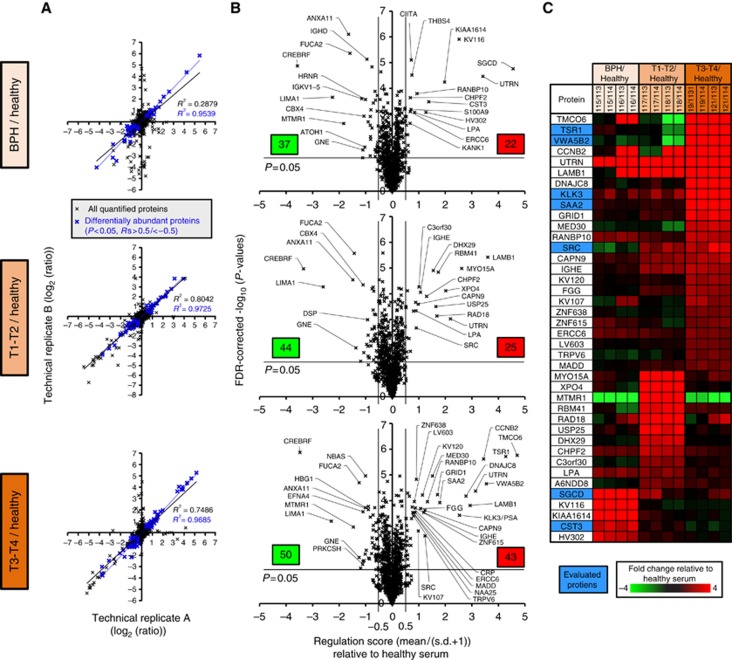
Summary of the reproducible differential serum protein abundance observed in BPH, T1–T2 and T3–T4 relative to healthy serum.(A) The reproducibility between technical replicates for all proteins, highlighting those considered differentially abundant (blue), relative to healthy serum (labels 113 and 114). (B) Volcano plots highlighting significantly, differentially abundant proteins plotting regulation scores (Rs) and −log10(P-values) of the four ratios derived from the technical/biological replicates for BPH, T1–T2 and T3–T4 relative to healthy donor serum. A total of 72 and 82 proteins demonstrated significant differential abundance (Rs>0.5 or Rs<−0.5, P<0.05) in at least one of the three conditions, respectively, totalling 151 distinct differentially abundant proteins. (C) The top 40 significantly (P<0.05) overabundant proteins, sorted by regulation score, across the BPH, T1–T2 and T3–T4 samples relative to healthy serum. Highlighted proteins are the seven selected for further validation by ELISA.